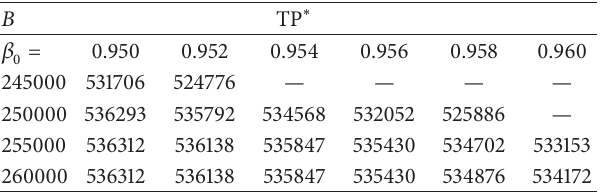
Table6:Effectofchanging 𝐵 fordifferentvaluesof 𝛽 0 ontheoptimal policy.